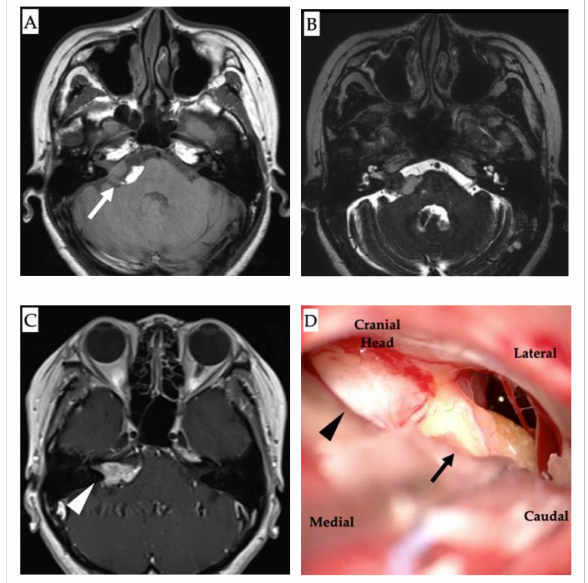
Figure 2. Magnetic resonance imaging (MRI) and intraoperative images. ( A ): Non-contrast axial T1-weighted MRI showing a hyperintense lesion in the right cerebellopontine angle alongside the brainstem lipoma (white arrow). ( B ): T2-weighted image showing the lipoma as a heterogeneous sig- nal intensity lesion. ( C ): Contrast T1-weighted MRI showing a multicystic tumor with homogeneous enhancement (white arrowhead). ( D ): Intraoperative findings showing the tumors: neurinoma (black arrowhead) and lipoma (black arrow).